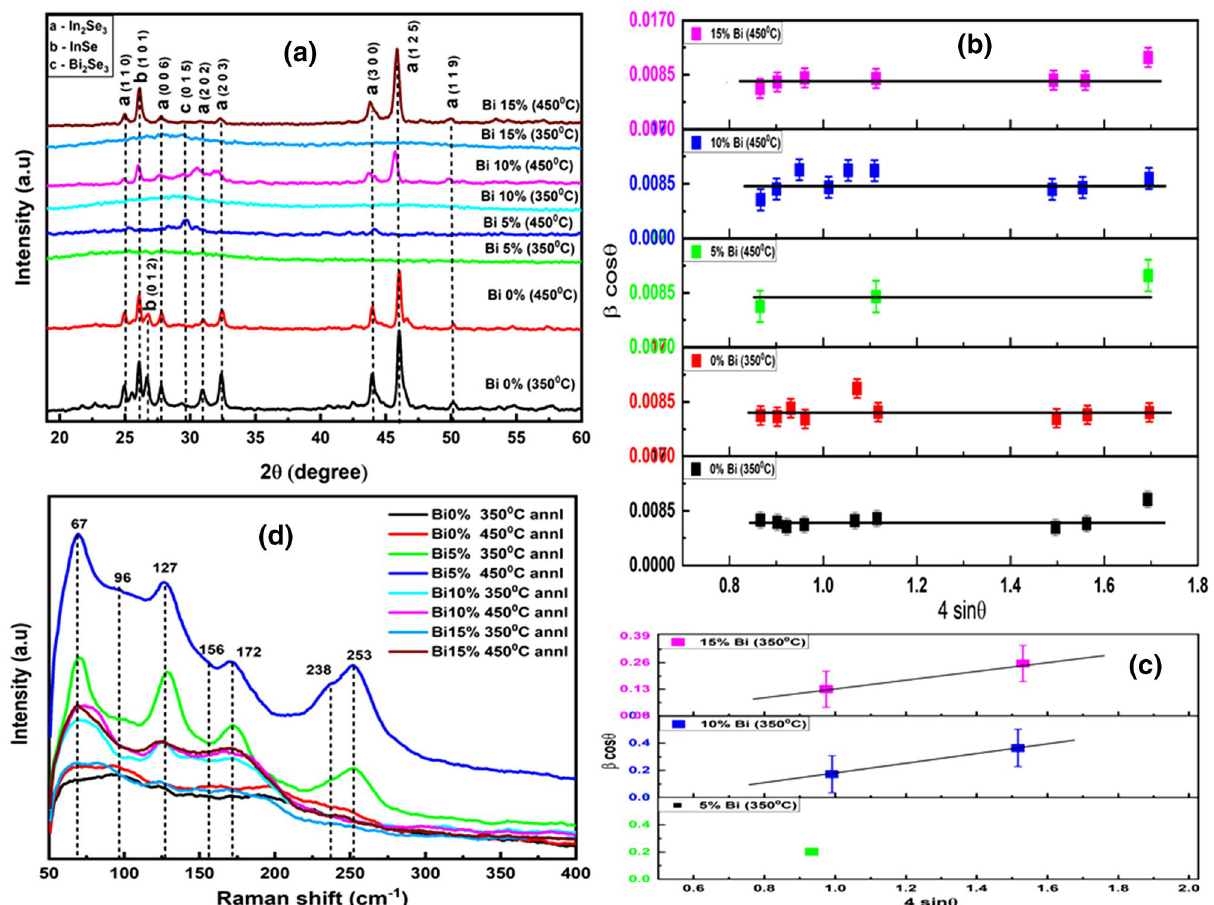
Figure 1. ( a ) XRD patterns, ( b ) Williamson-Hull plot for crystalline and ( c ) amorphous peaks, ( d ) Raman spectra of the annealed Bi x In 35-x Se 65 thin films.